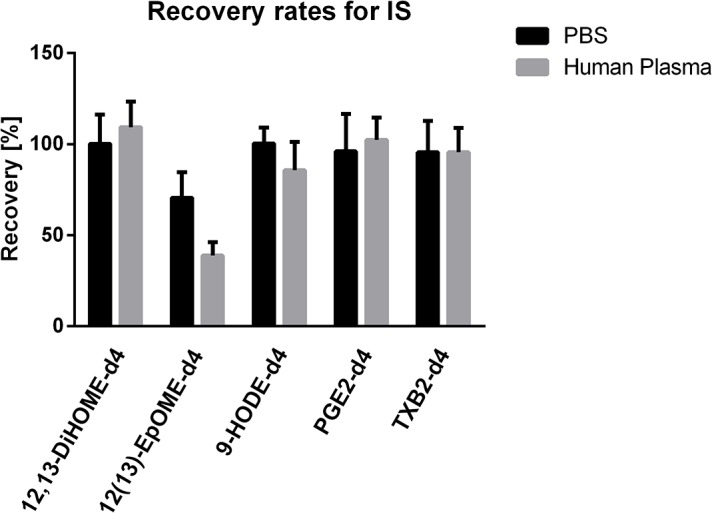
Average recovery rates for deuterated internal standards (IS) in PBS (n = 5) and human plasma (n = 24) Expressed as mean±SEM.